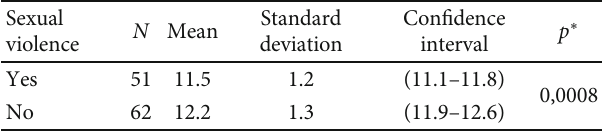
Figure 2: Correlation between the age at menarche and the age at fi rst pregnancy of adolescents attended at a Basic Health Unit (age at menarche × age at fi rst pregnancy). Table 2: Correlation between age at menarche and the experience of sexual violence among adolescents attended at a Basic Health Unit.